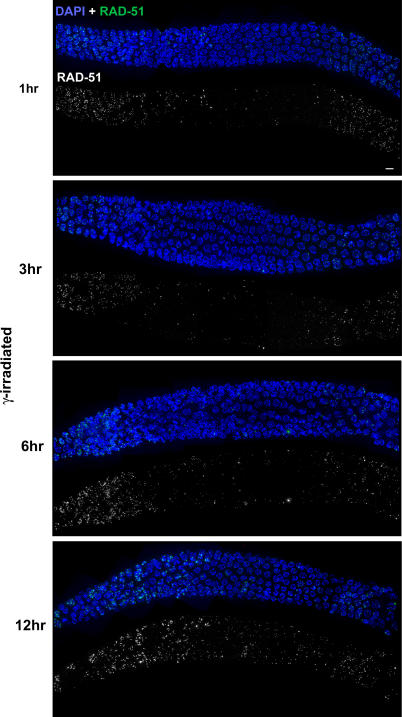
Time Course Analysis of IR-Induced RAD-51 Foci in the Constrained Region of spo-11; rad-50 Germ LinesImages show portions of spo-11; rad-50 germ lines, centered on the constrained region and also including a subset of premeiotic nuclei (left) and late pachytene nuclei (right). Germ lines were fixed at the indicated times following exposure to 1 krad γ-irradiation and stained with DAPI and RAD-51 antibody. An obvious RAD-51-dark region in the central segment of the germ line is readily discernable at the 1, 3 and 6 h time points, but not at the 12 h time point. Scale bar = 5 μm.